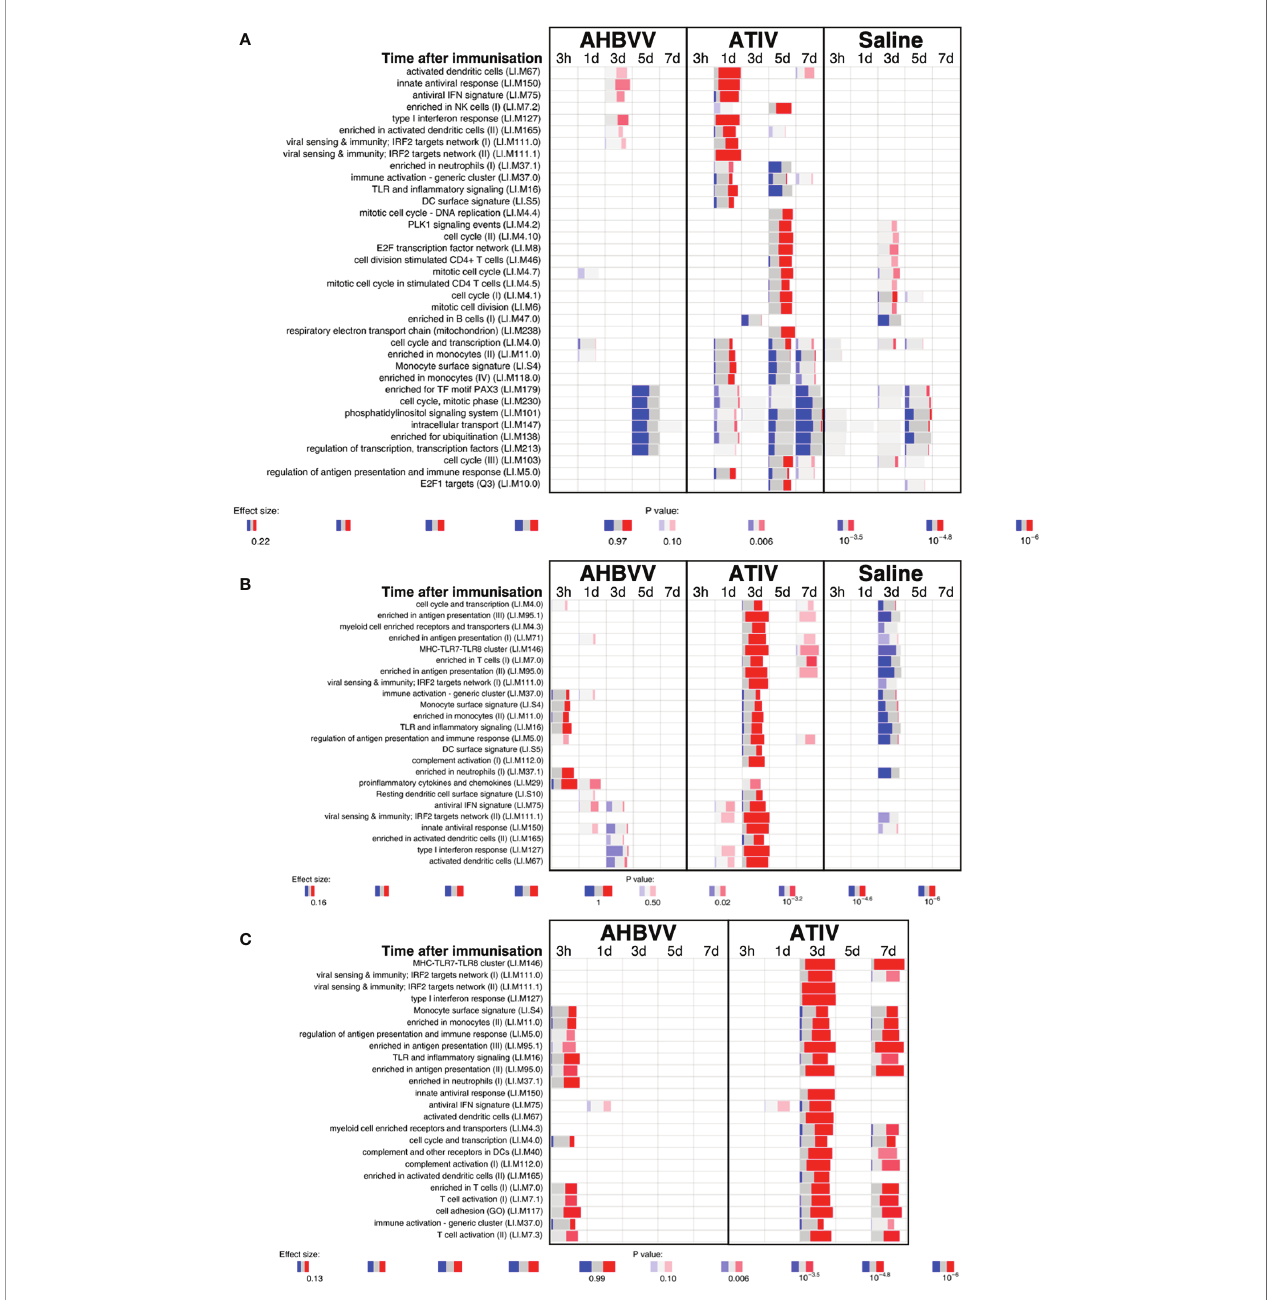
FIGURE 6 | Gene expression in whole blood and muscle at different time points after immunization. Gene set enrichment analysis of signatures at different time points after immunization in the whole blood [pre-immunization time point control (A) ] and immunized leg muscle biopsy [ (B) paired unimmunized leg biopsy as control; (C) saline group as control]. Bar sizes correspond to effect size (AUC) in the enrichment and intensity of color to the adjusted p value of enrichment (stronger color corresponds to lower adjusted p value). Red and blue boxes indicate fractions of genes that have, respectively, a signi fi cantly higher or lower expression in the test group compared to